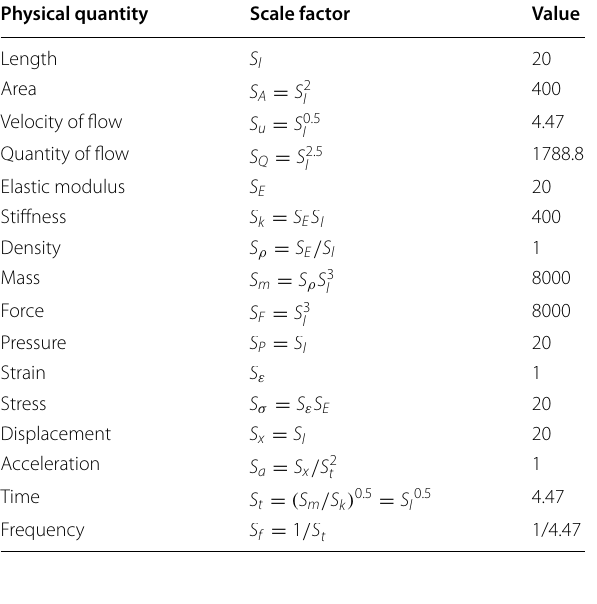
Table 1 Similitude ratios of physical quantities for the dynamic test.